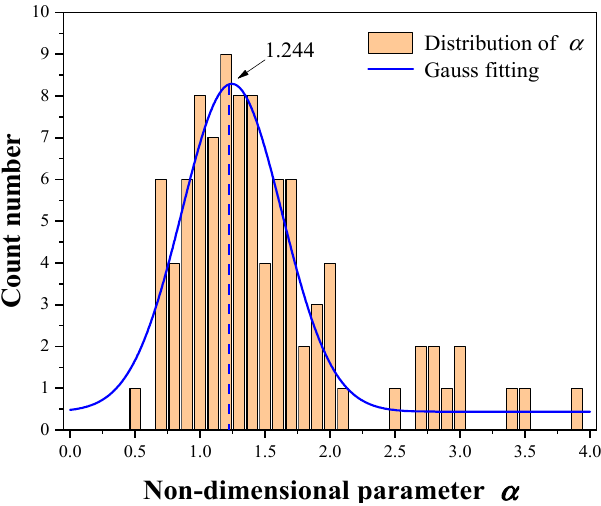
Figure 5. Effect of 𝑏/𝐷 on 𝜇 (cid:2912)/(cid:2888) by deriving the results of FEA for 𝜃 = 90° .